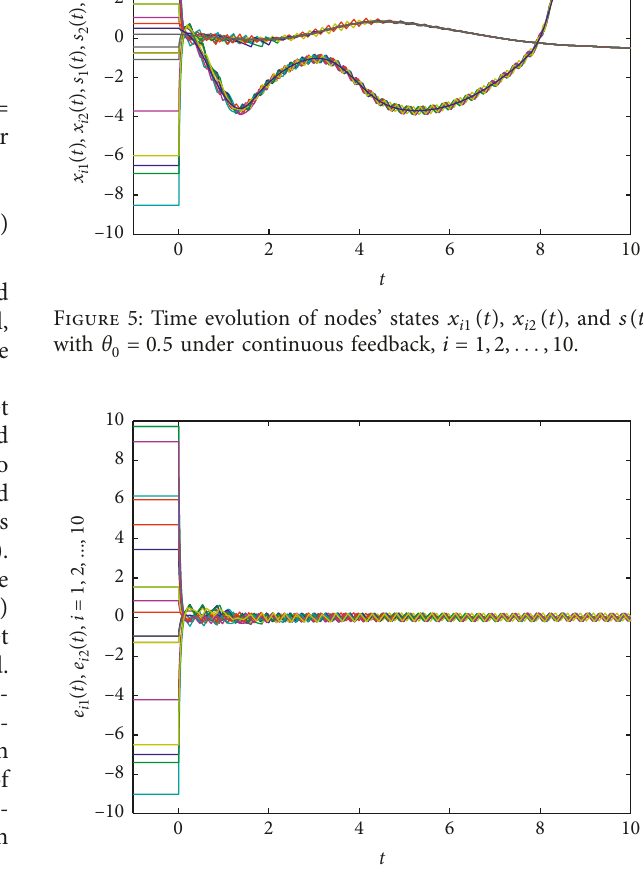
Figure 6: Time evolution of synchronization errors e � 0 . 5 under continuous feedback, i � 1 , 2 , ... , with θ 0